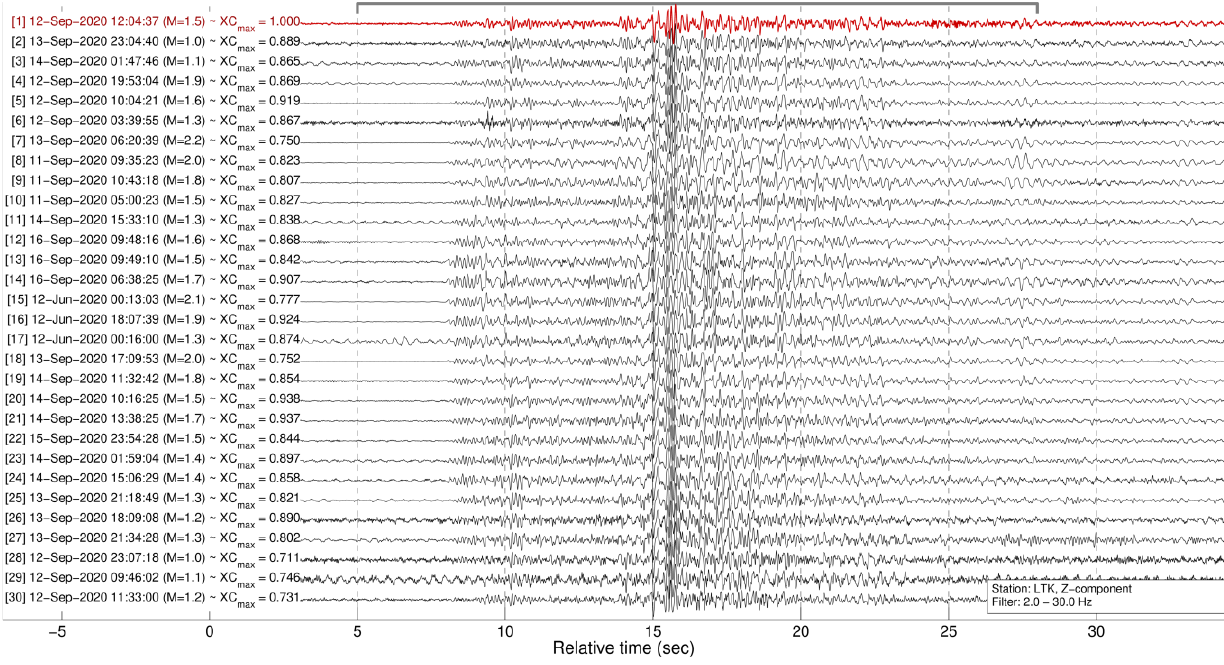
Figure A10. Waveforms of template “2020-09-12-12-04-30” (top, red) and 29 associated detections (black), belonging to multiplet #194 of CAT3, formed with farthest-neighbor linkage at a similarity threshold of 0.50 (see also Figure 10 for the temporal distribution of this multiplet). The recordings are from the vertical component of station LTK, filtered between 2 and 30 Hz.